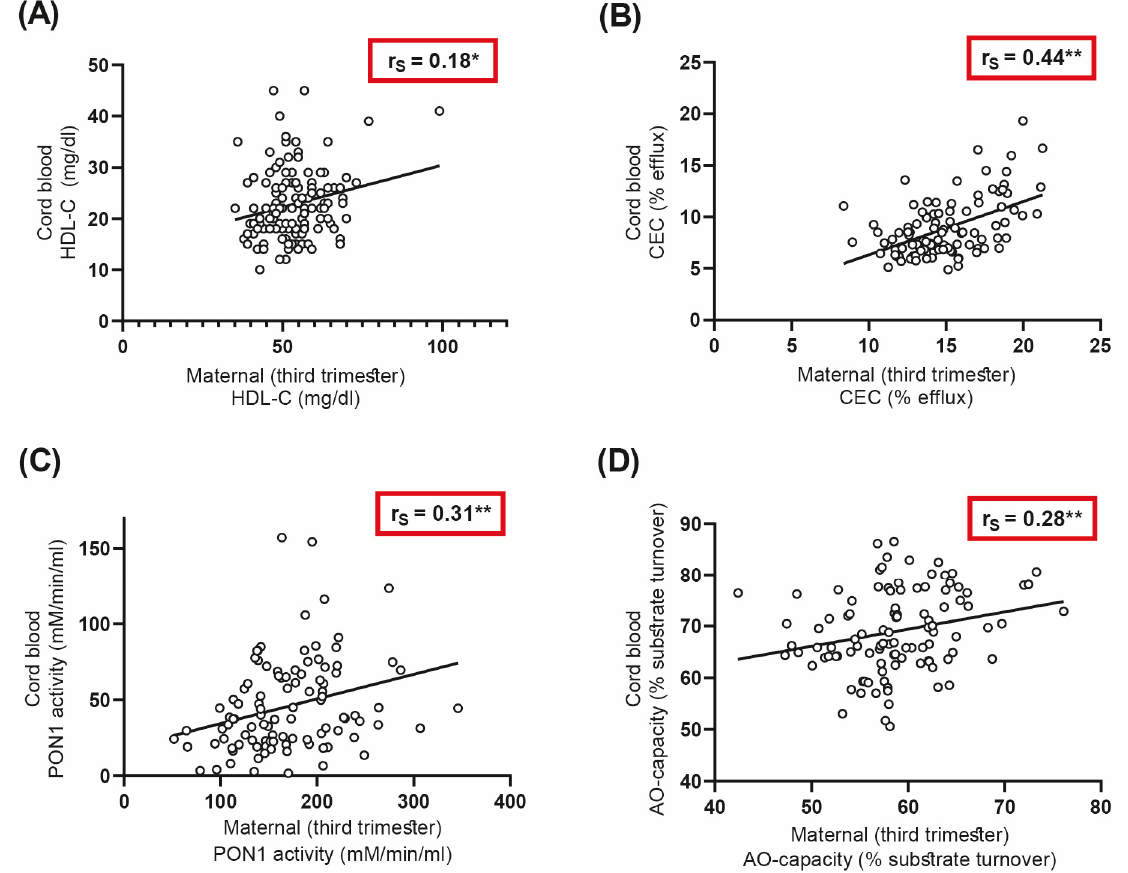
Figure 3. Spearman correlation analyses between maternal and cord blood HDL-related parameters and serum functionalities ( A ) HDL-C, ( B ) CEC (cholesterol efflux capacity), ( C ) paraoxonase-1 (PON1) activity, and ( D ) serum antioxidative capacity. * p < 0.05, ** p < 0.01.